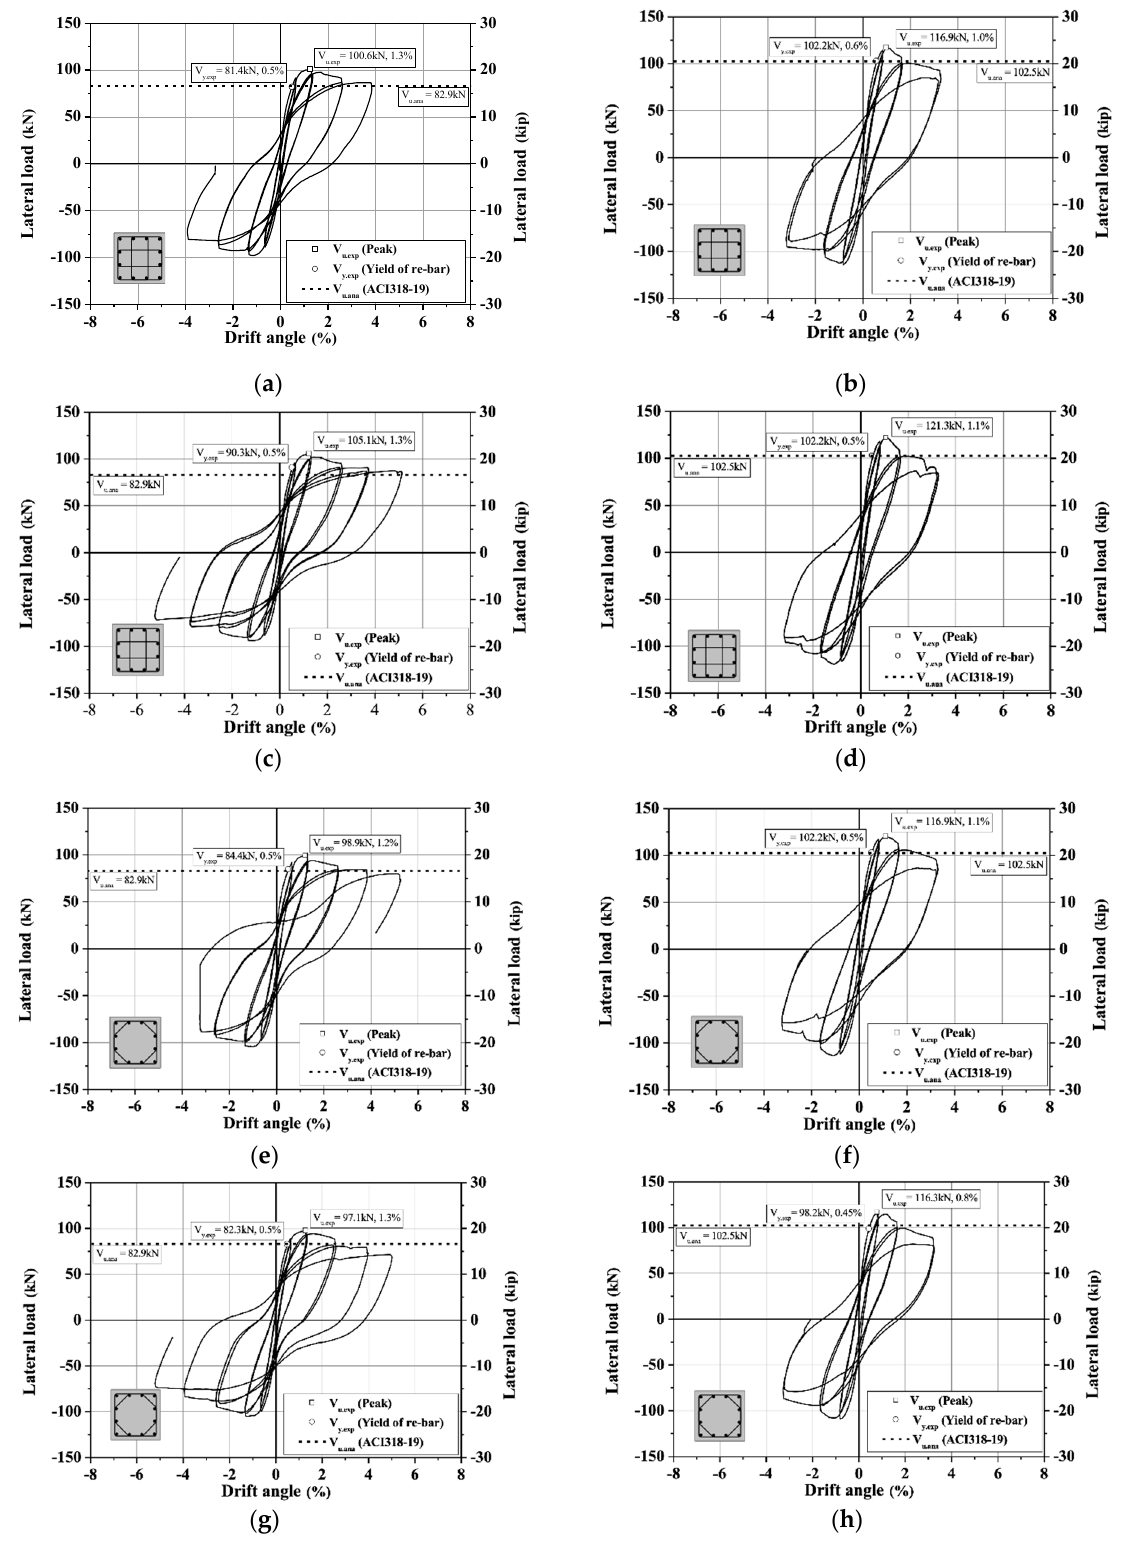
Figure 5. Relationship of lateral load-drift angle of specimens: ( a ) NH20; ( b ) NH30; ( c ) UH20; ( d ) UH30; ( e ) NS20; ( f ) NS30; ( g ) US20; ( h ) US30.